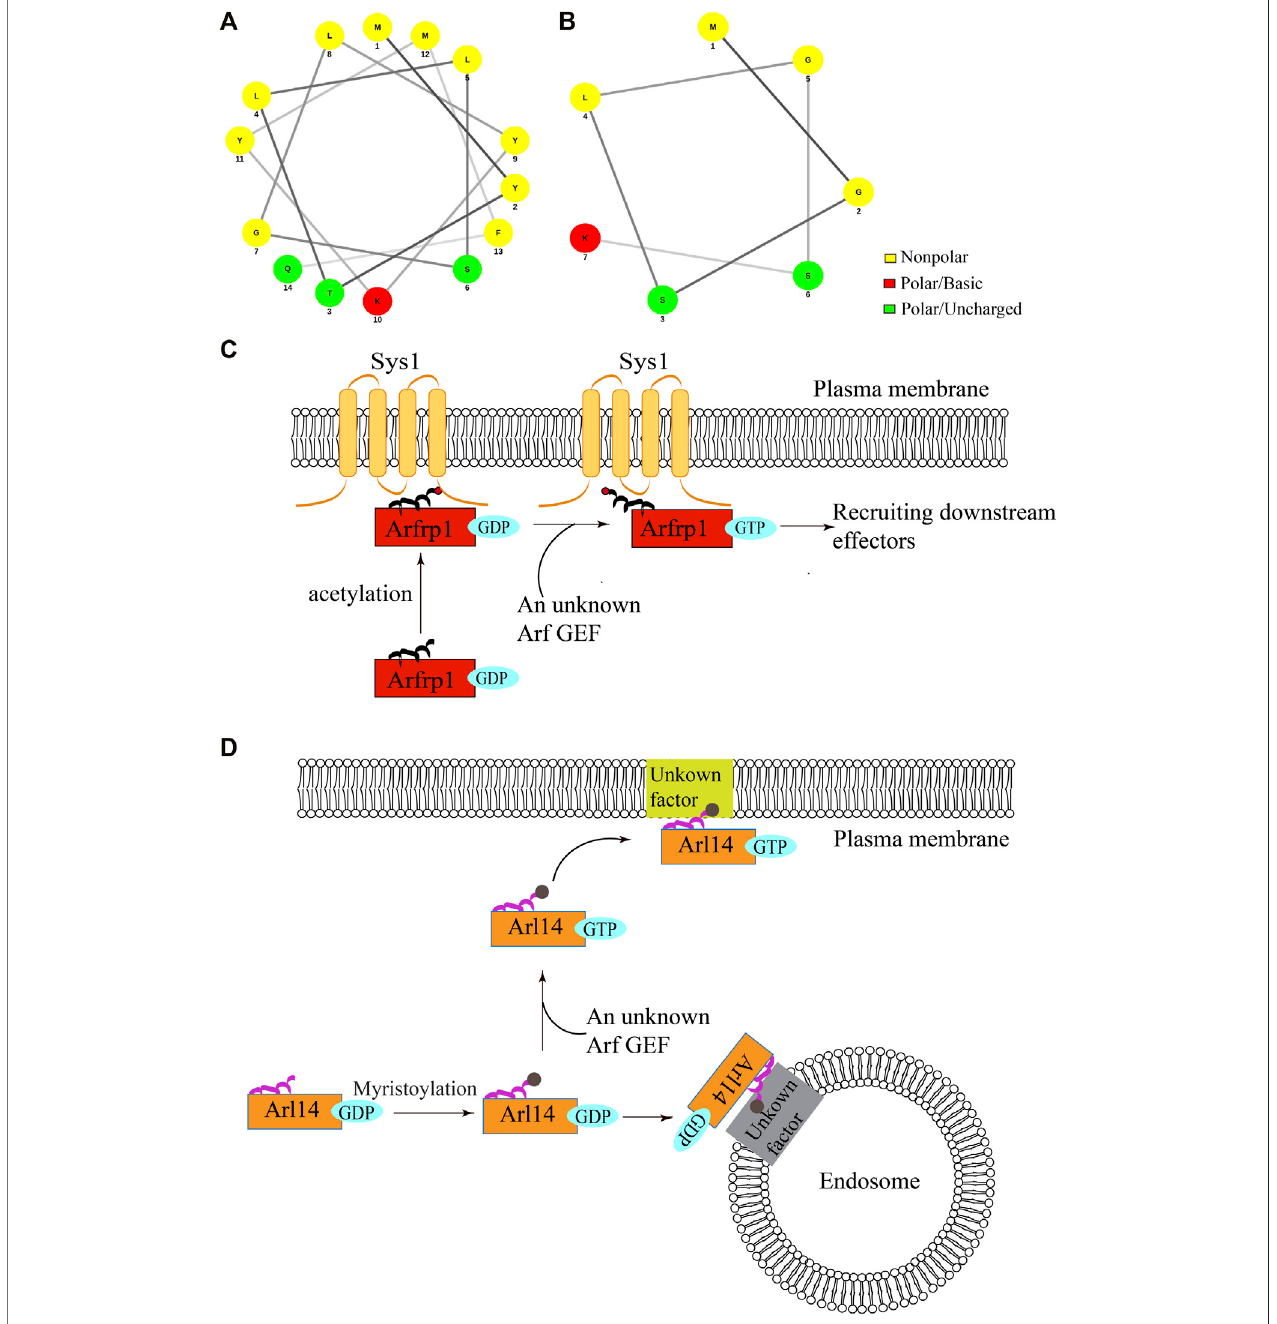
FIGURE 1 | The proposed model of membrane recruitment of Arfrp1 and Arl14. (A,B) The helical wheel diagram of N-terminal region of human Arfrp1 (A) and Arl14 (B) .Thediagram wasdrawnfrom thefollowing website: http://lbqp.unb.br/NetWheels/. (C,D) Theproposedmodel ofmembranerecruitmentofArfrp1andArl14. Upon acetylation at the N-terminal helix, Arfrp1 interacts with the transmembrane protein Sys1 to be recruited to the TGN (C) . After myristoylation, GDP-bound Arl14 is preferentially recruited to the endosomes and GTP-bound Arl14 is preferentially recruited to the plasma membranes (D) .